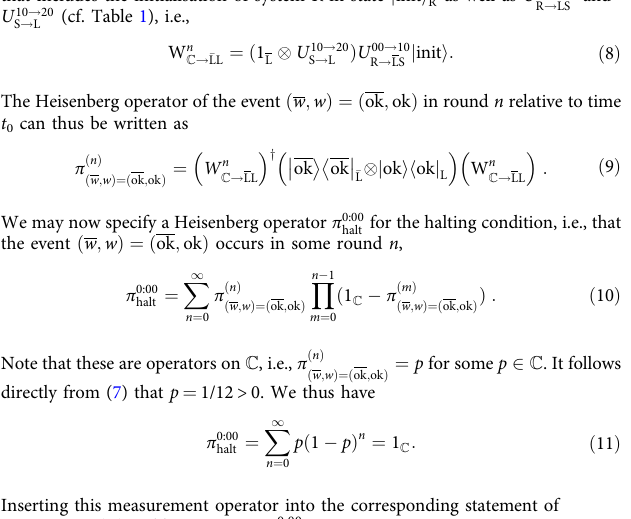
Time evolution of F ’ s lab L